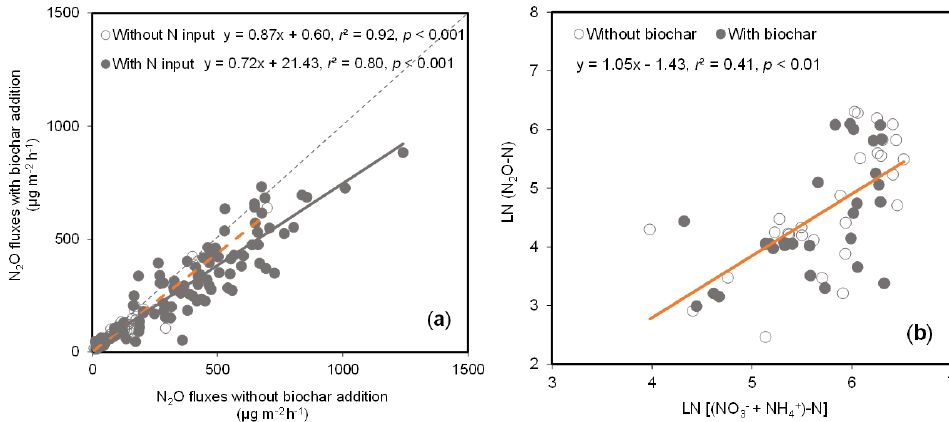
Figure 3. Soil release of N 2 O fluxes ( a ) in biochar-amended treatments against those without biochar-amended treatments and its dependence on soil mineral N contents (NO 3 − -N+NH 4+ -N, b ). Both soil N 2 O-N fluxes and mineral N contents were all log-transformed. The thin dotted line represents the 1:1 line where the values from biochar-amended and unamended soils are equal, while the solid and dotted lines in bold represent linear regressions for individual observations. LN means natural logarithm.